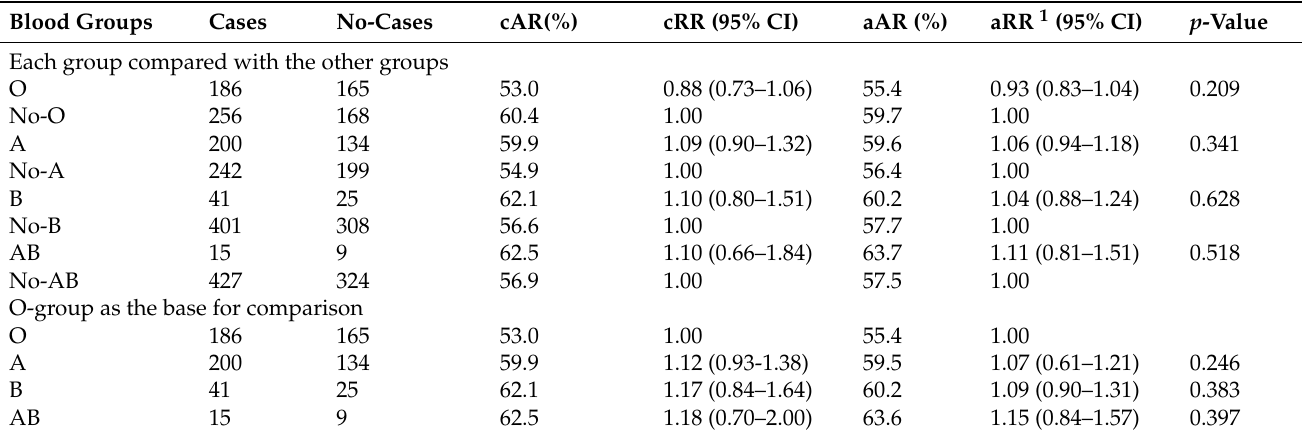
Table 2. Incidence of COVID-19 cases by ABO blood groups. Inverse probability-weighted regression. Crude attack rate (cAR) and adjusted (aAR). Crude relative risk (cRR) and adjusted (aRR); 95% confidence interval (CI). Borriana COVID-19 cohort,